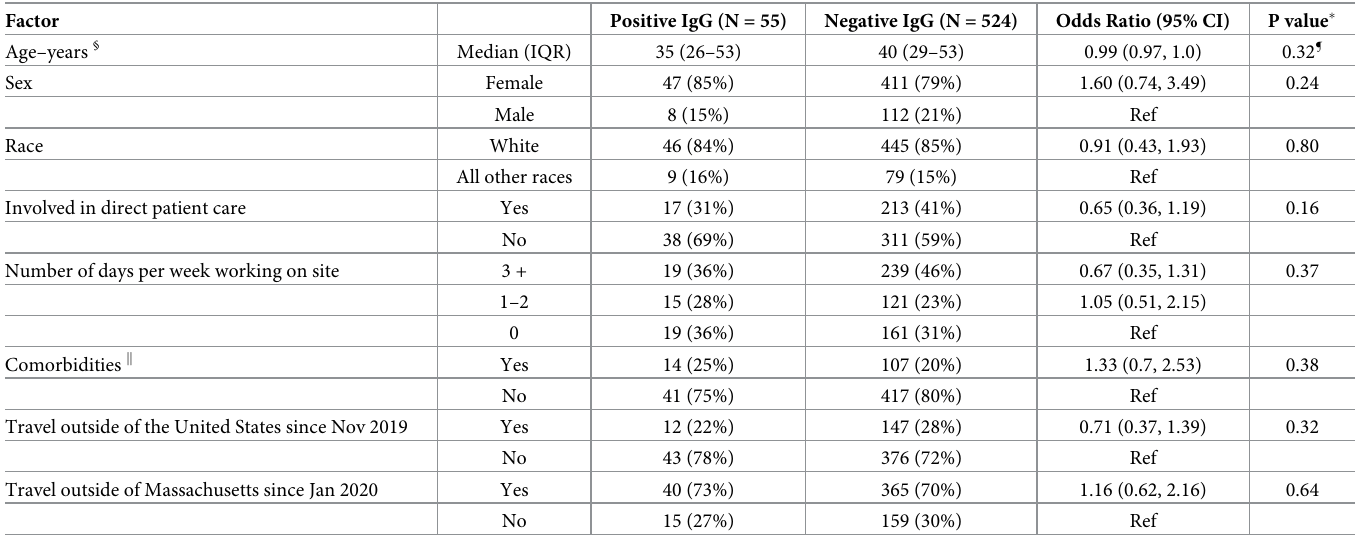
Participants who didn’t get vaccinated at time of blood drawl were included in the analysis. Number of missing: Age = 5, Sex = 1, Number of days per week working on site = 5, Travel outside of the United States = 1. § Odds ratio per unit increase. Odds ratios were estimated from logistic regression. � P-value from the chi-square test unless specified. ¶ P-value from Wilcoxon rank sum test.